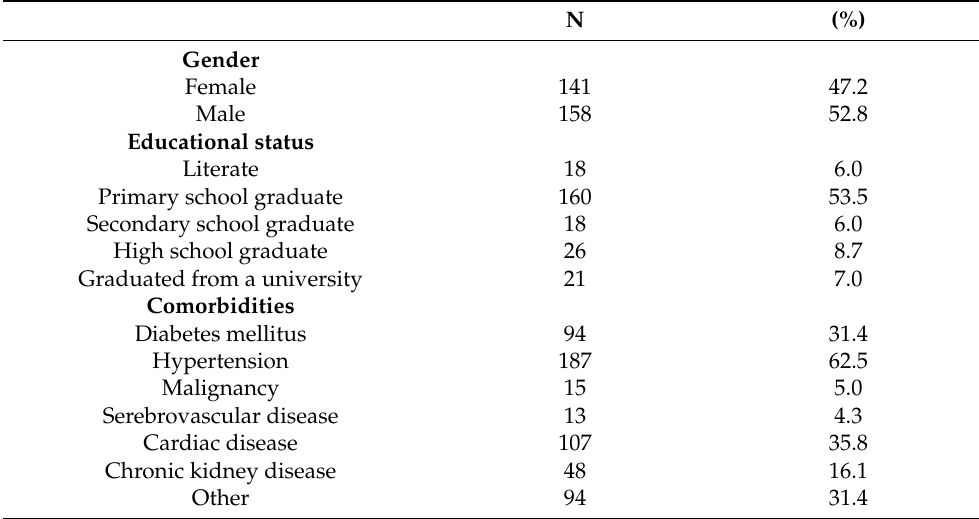
Table 2. Demographical properties of the